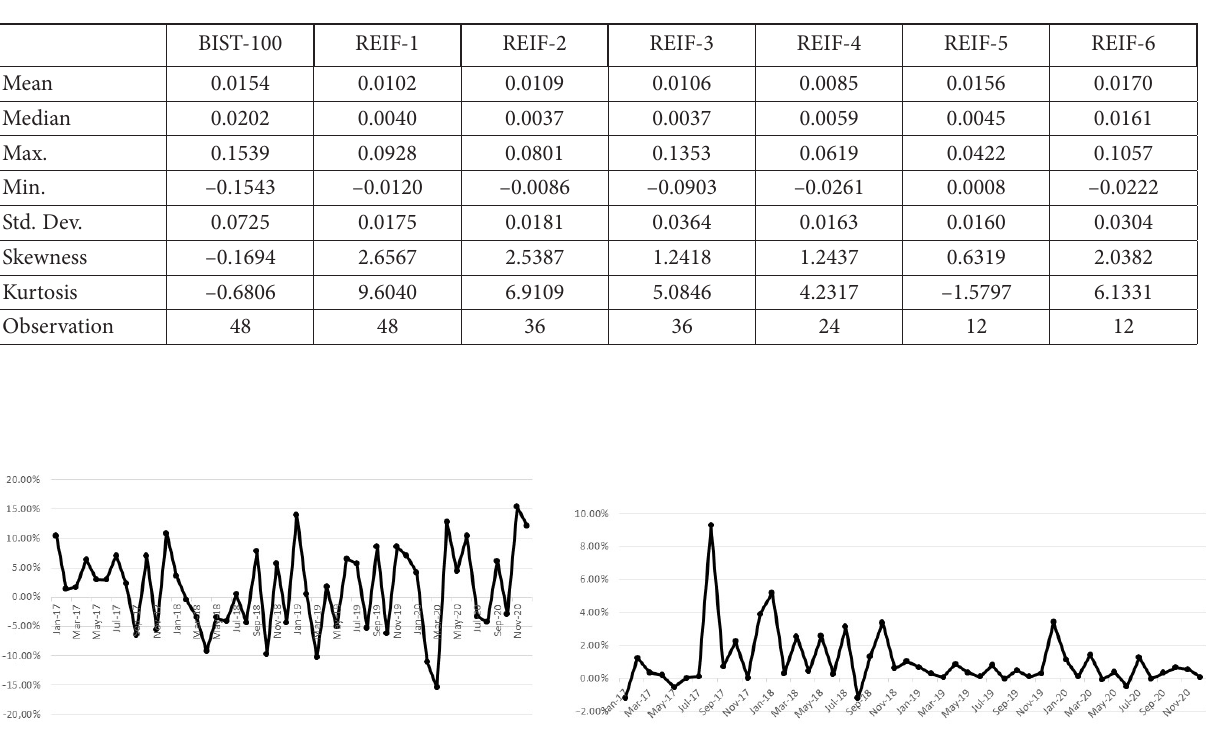
Table 1. Summary of basic performance statistics during January 2017–October 2020